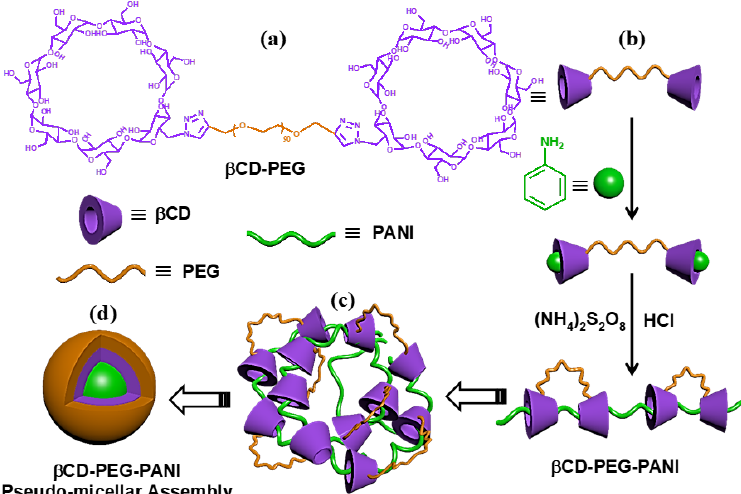
Figure 14. ( a ) Molecular structure of β CD-PEG, ( b – d ) simplified illustration of formation and assembly of β CD-PEG-PANI. Here, the involvement of β CD units (attached to PEG chains), during polymerization is considered random. Reproduced with permission from [90].